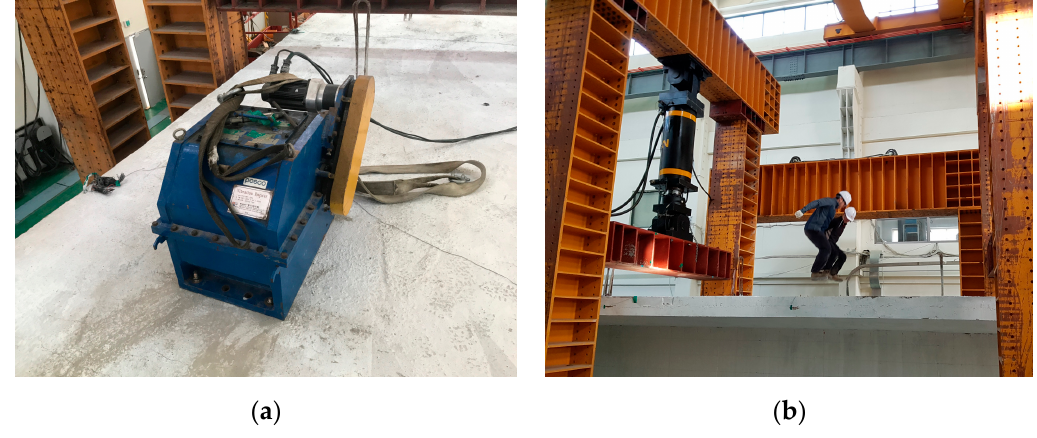
Figure 15. Forced vibration methods: ( a ) exciter; ( b ) manpower.